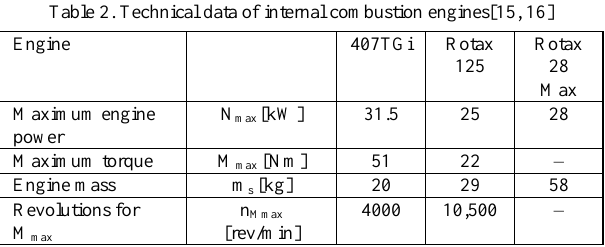
Table 2. Technical data of internal combustion engines[15, 16]